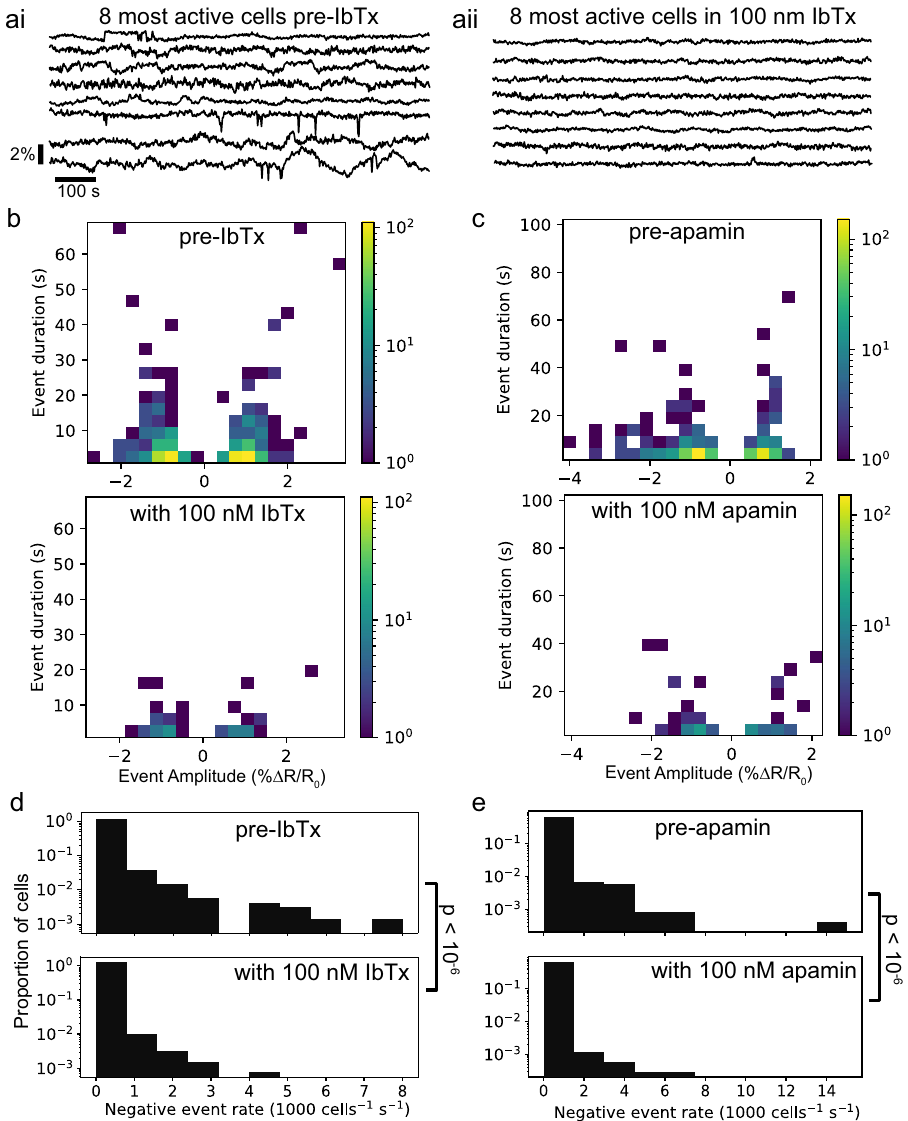
Fig. 7 KCa channel blockade decreased V m fl uctuations in MDA-MB-231 cells. ai , aii Example V m time courses from the 8 most active cells in an acquisition before ( ai ) and with ( aii ) 100 nM IbTx. b , c Log-scaled 2D histograms of the amplitude and duration of detected events before (upper) and with (lower) 100 nM IbTx (left) and 100 nM apamin (right). d , e Log scaled histograms of the − VE event rate per cell for pre- and post-application of 100 nM IbTx (left) and 100 nM apamin